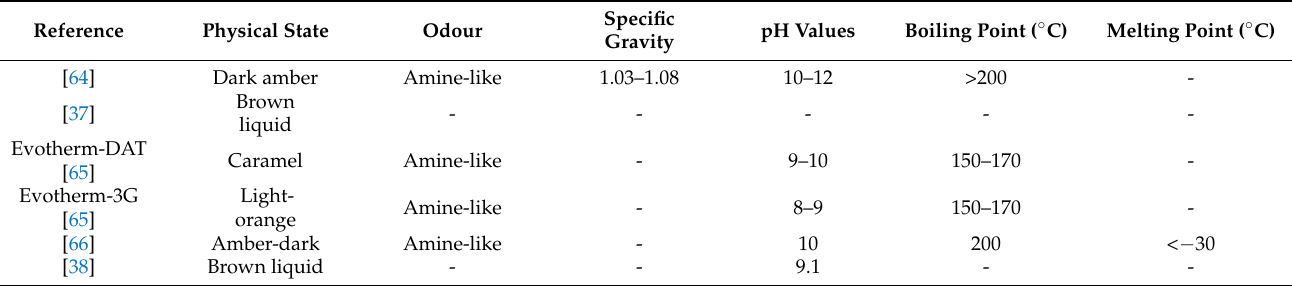
Table 13. Properties of sulphur based on previous studies.